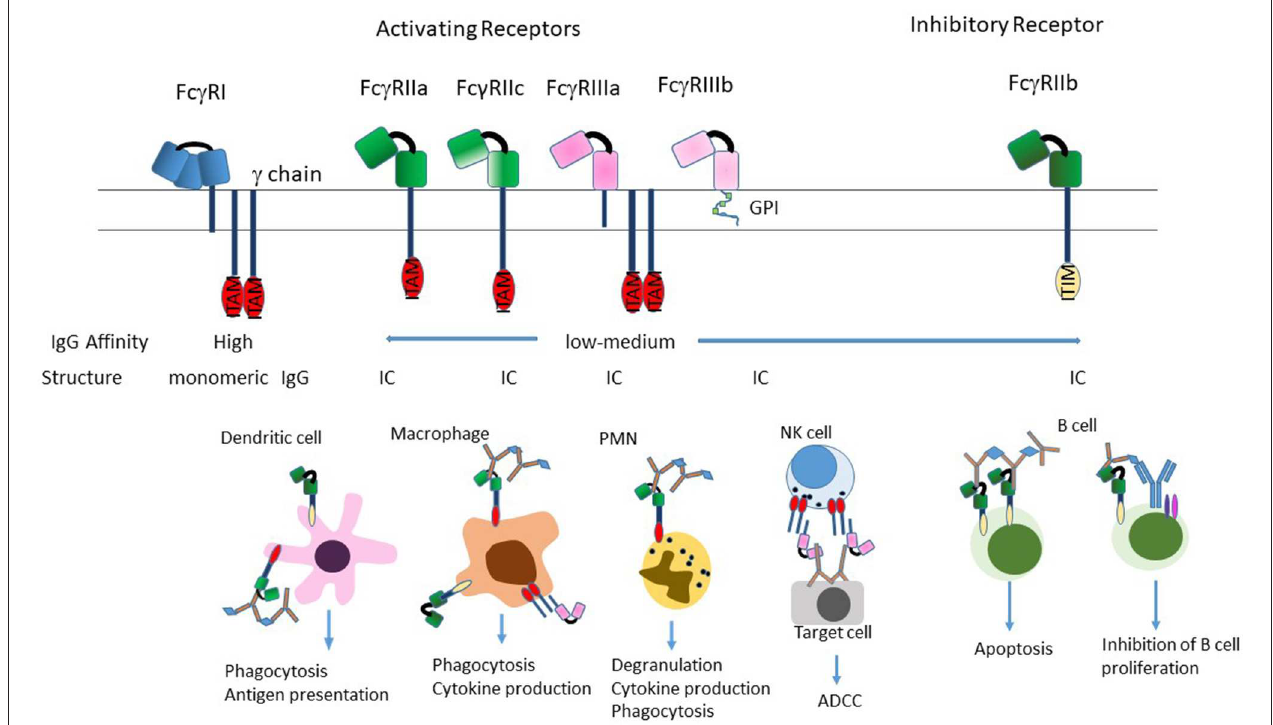
FIGURE 2 | Structure of Fc γ Rs. The Fc γ R’s differ in their affinity for IgG; Fc γ RI is a high-affinity receptor and is the only one that can effectively bind monomeric IgG; the two low-affinity receptors Fc γ RII and Fc γ RIII preferentially bind IgG in the form of immune complexes. Fc γ RI and Fc γ RIIIa exist as transmembrane proteins each non-covalently linked to a common FcR γ subunit. The γ subunit exists as a homodimer containing an immunoreceptor tyrosine-based activation motif (ITAM) within its intracellular domain. Fc γ RII exists on the cell surface as a single chain with the ligand-binding region in the extracellular domain and either an ITAM (Fc γ RIIa), or an immunoreceptor tyrosine-based inhibition motif (ITIM; Fc γ RIIb) in the intracytoplasmic domain necessary for signal transduction reviewed in (33). Fc γ RIIIb is the only receptor anchored to the membrane via a glycosylphosphatidylinisotol (GPI) link (34). Stimulation of the Fc γ Rs by ICs induces a variety of effector functions that varies by cell type. Most cells express a combination of activating and inhibitory receptors, which allows fine-tuning of the response to ICs. The exception to this is NK cells, which only express activating receptors, and B cells that only express the inhibitory receptor.